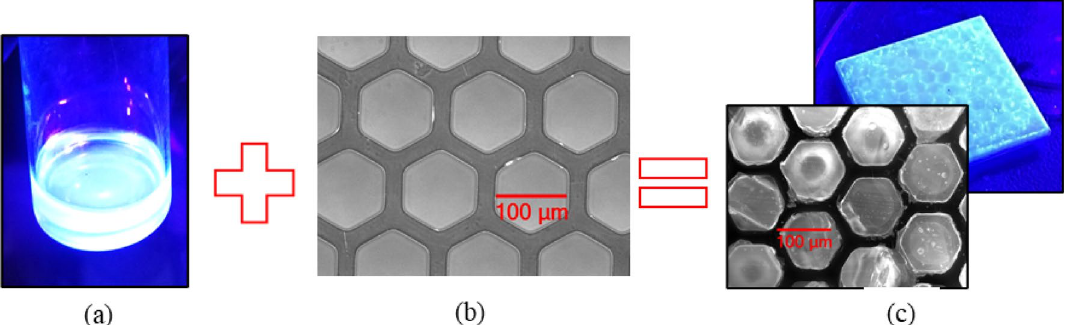
Figure 1. The production of the dual imaging detector using PEALPB produced by wet chemistry ( a ) and microcapillary plates ( b ) to produce a high-resolution imaging detector ( c ) with single-crystalline PEALPB